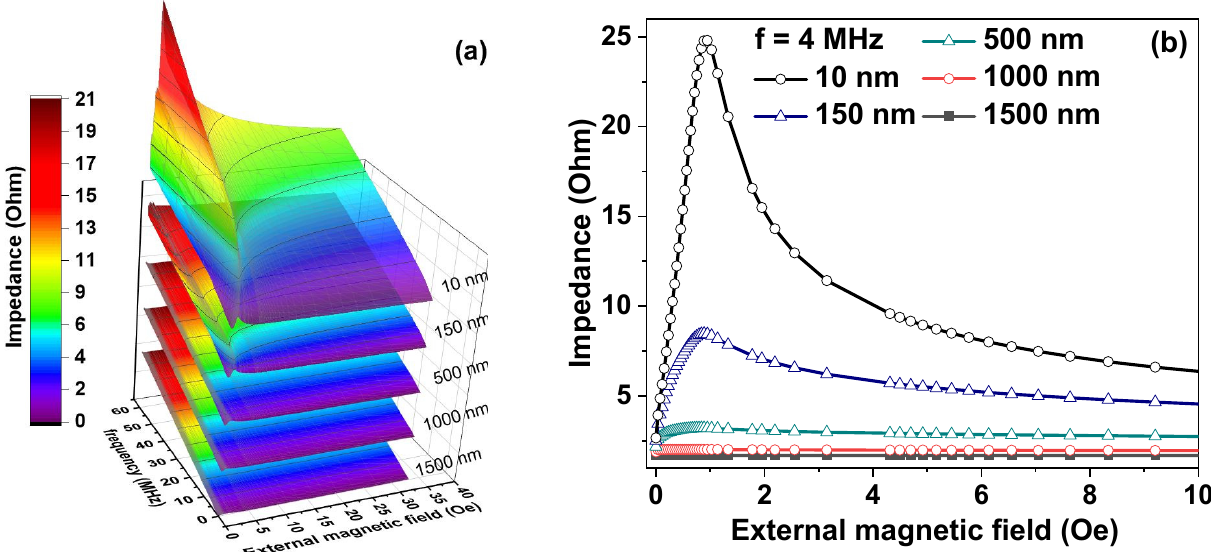
Figure 5. ( a ) Computing simulation of the dependence of the impedance modulus on the frequency and external magnetic field for different thickness of FeNi in the composite structure R-FeNi. ( b ) Computing modelling of absolute value of magnetoimpedance for frequency 4 MHz for different thicknesses of FeNi in the composite structure R-FeNi.